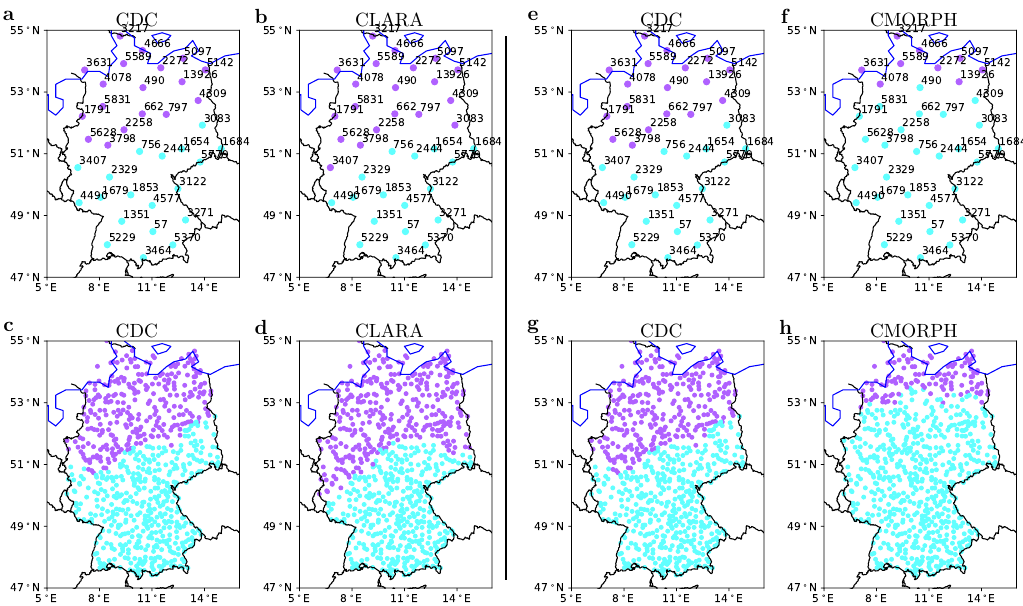
Figure 6. One sample from cross validation for clustering and classification of CDC stations over Germany using daily CLARA CTT and CMORPH precipitation data. ( a – d ) CLARA case and ( e – h ) CMORPH case.